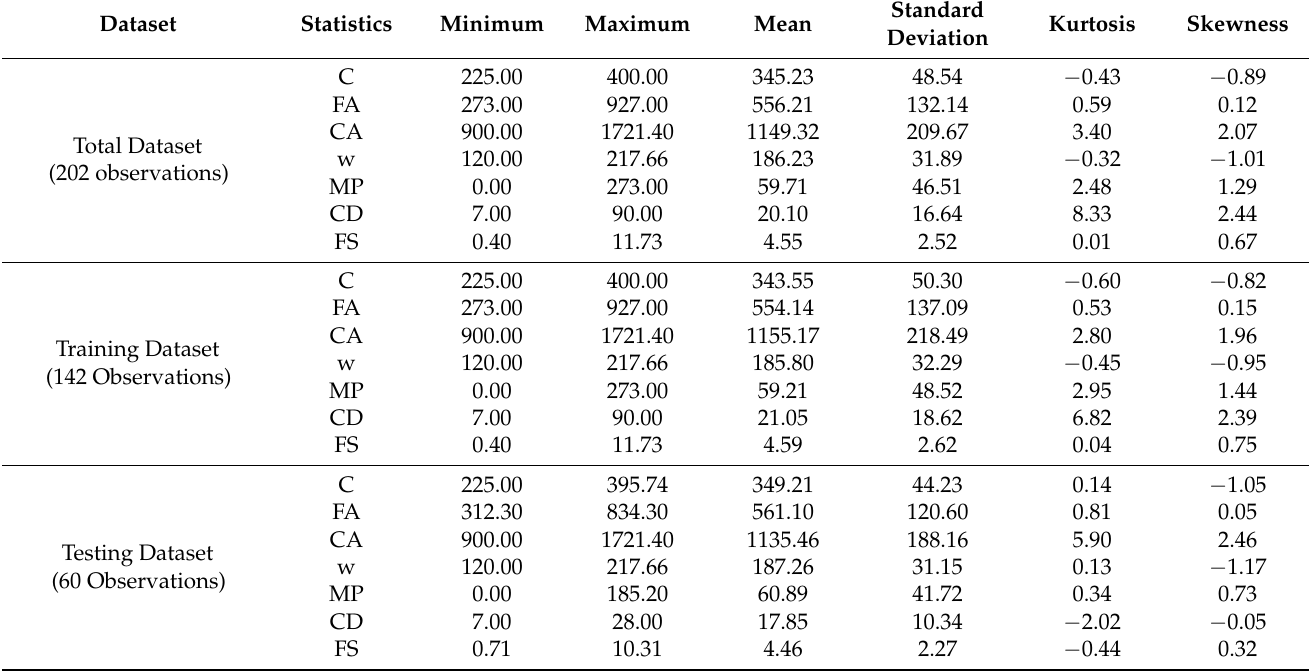
Table 7. Characteristics of